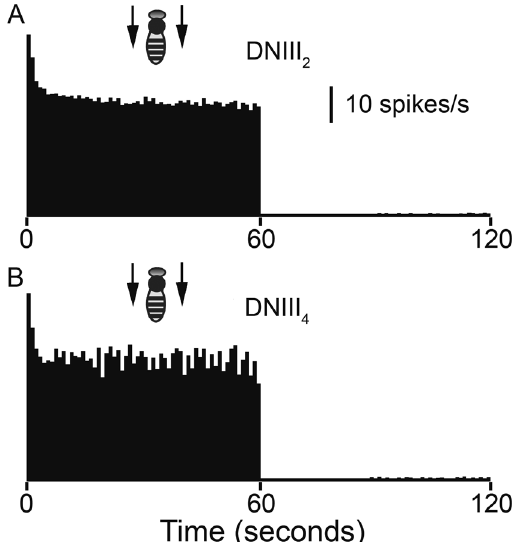
Figure 8. Response persistence. Peristimulus time histograms (PSTHs) showing the mean response amplitudes (6 repetitions in each cell) during 60 s of continuous grating motion at 200°/s for DNIII 2 ( A ) and DNIII 4 ( B ). Vertical bar = 10 spikes/s. The time bins in the PSTHs are 1 s in